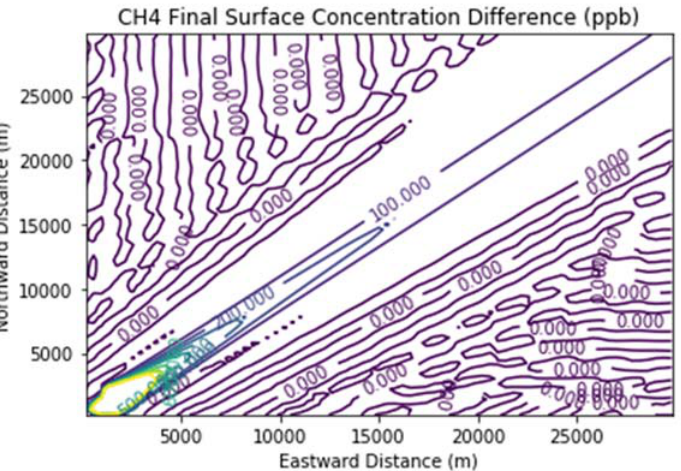
Figure 9. Methane difference plot between the Fugitives + Combustion and Combustion Only scenarios at the end of the 3 h simulation for the 30 km × 30 km domain.